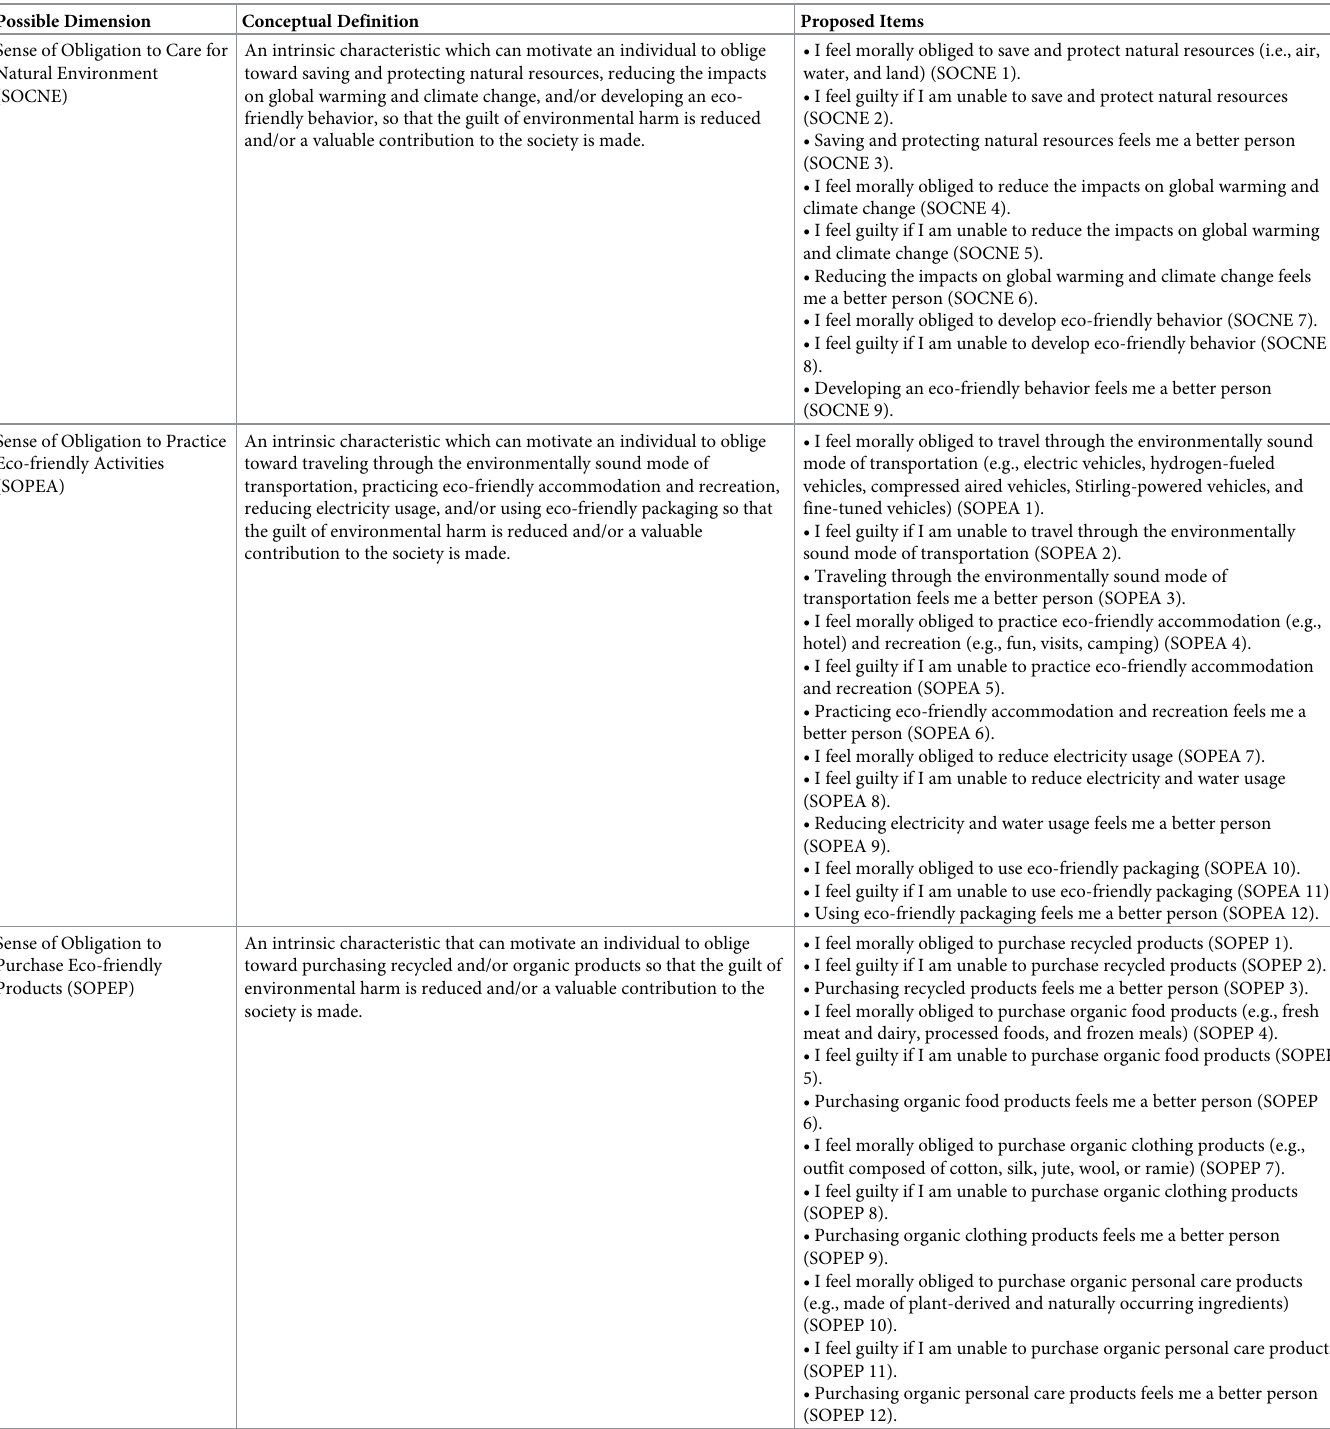
Table 2. The possible dimensions and pool of extracted